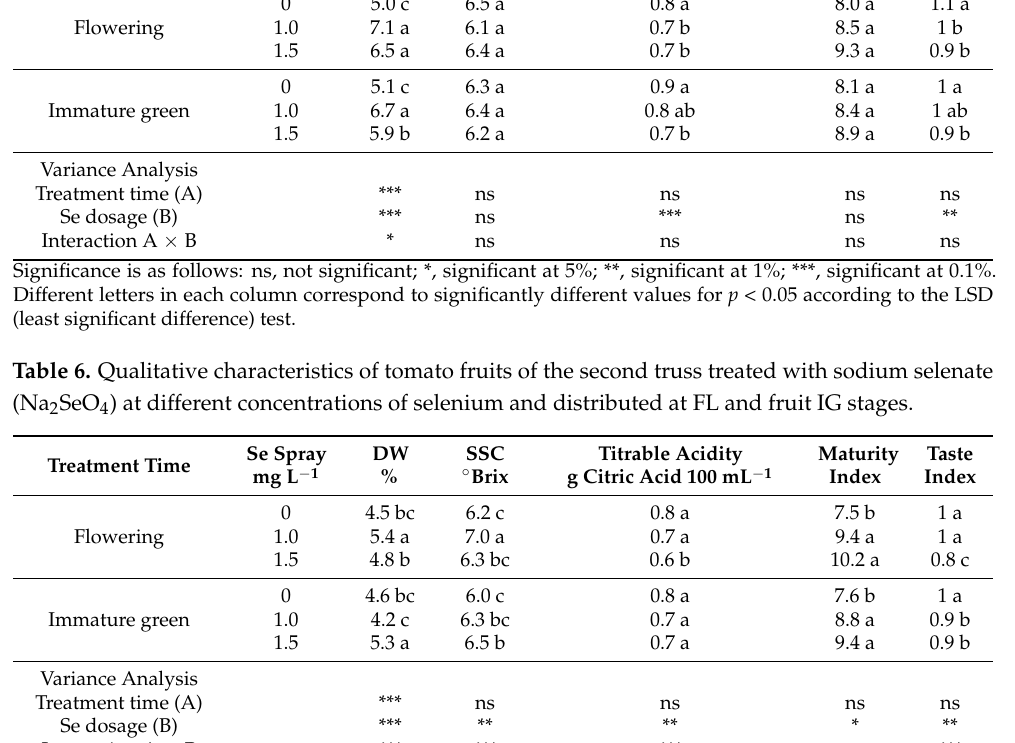
Table 5. Qualitative characteristics of tomato fruits of the first truss treated with sodium selenate (Na 2 SeO 4 ) at different concentrations of selenium and distributed at FL and fruit IG stages. Treatment Time